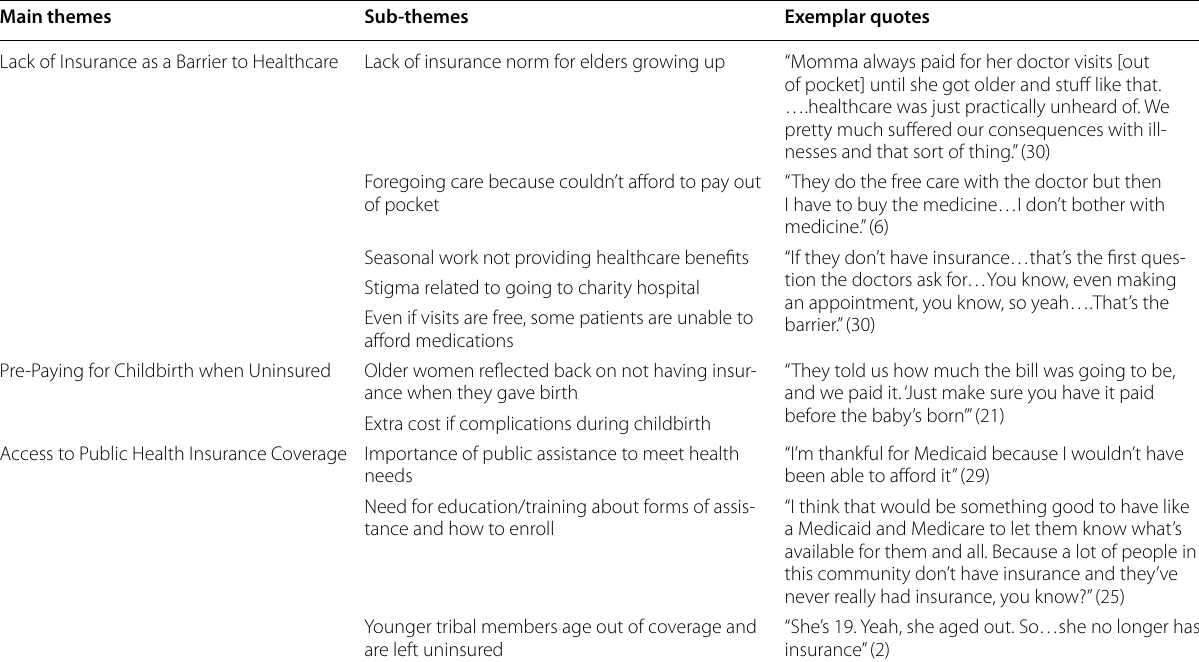
Table 1 Summary of study